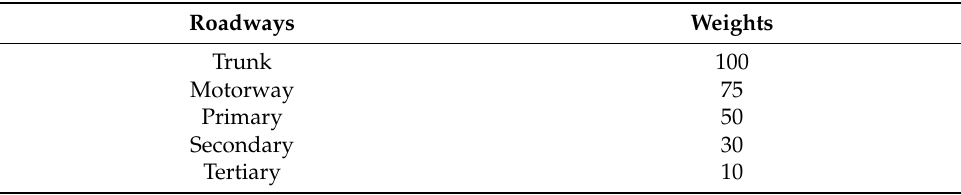
Table 1. Estimated weights indicating the traffic volume proxy based on AADT (Annual Average Daily Traffic) of each roadway